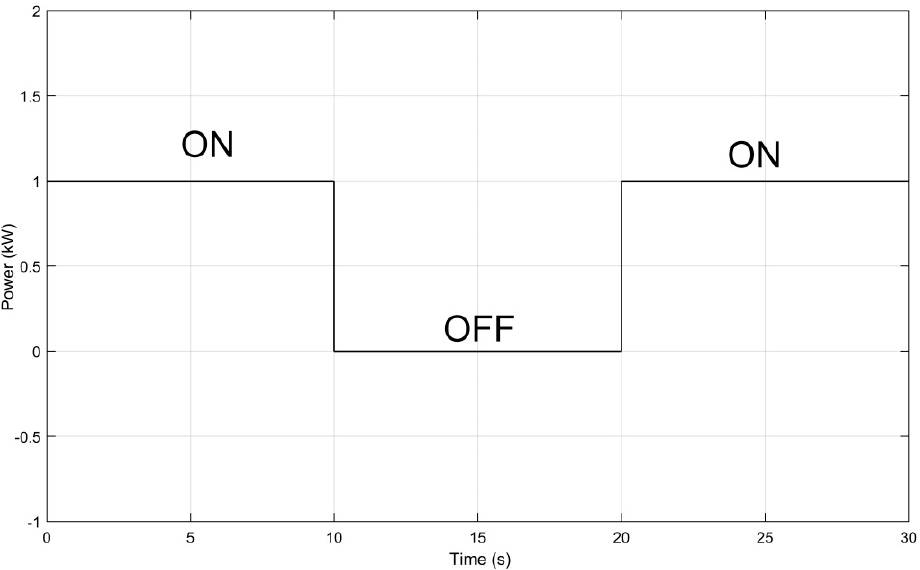
Figure 19. Operation state of module D.